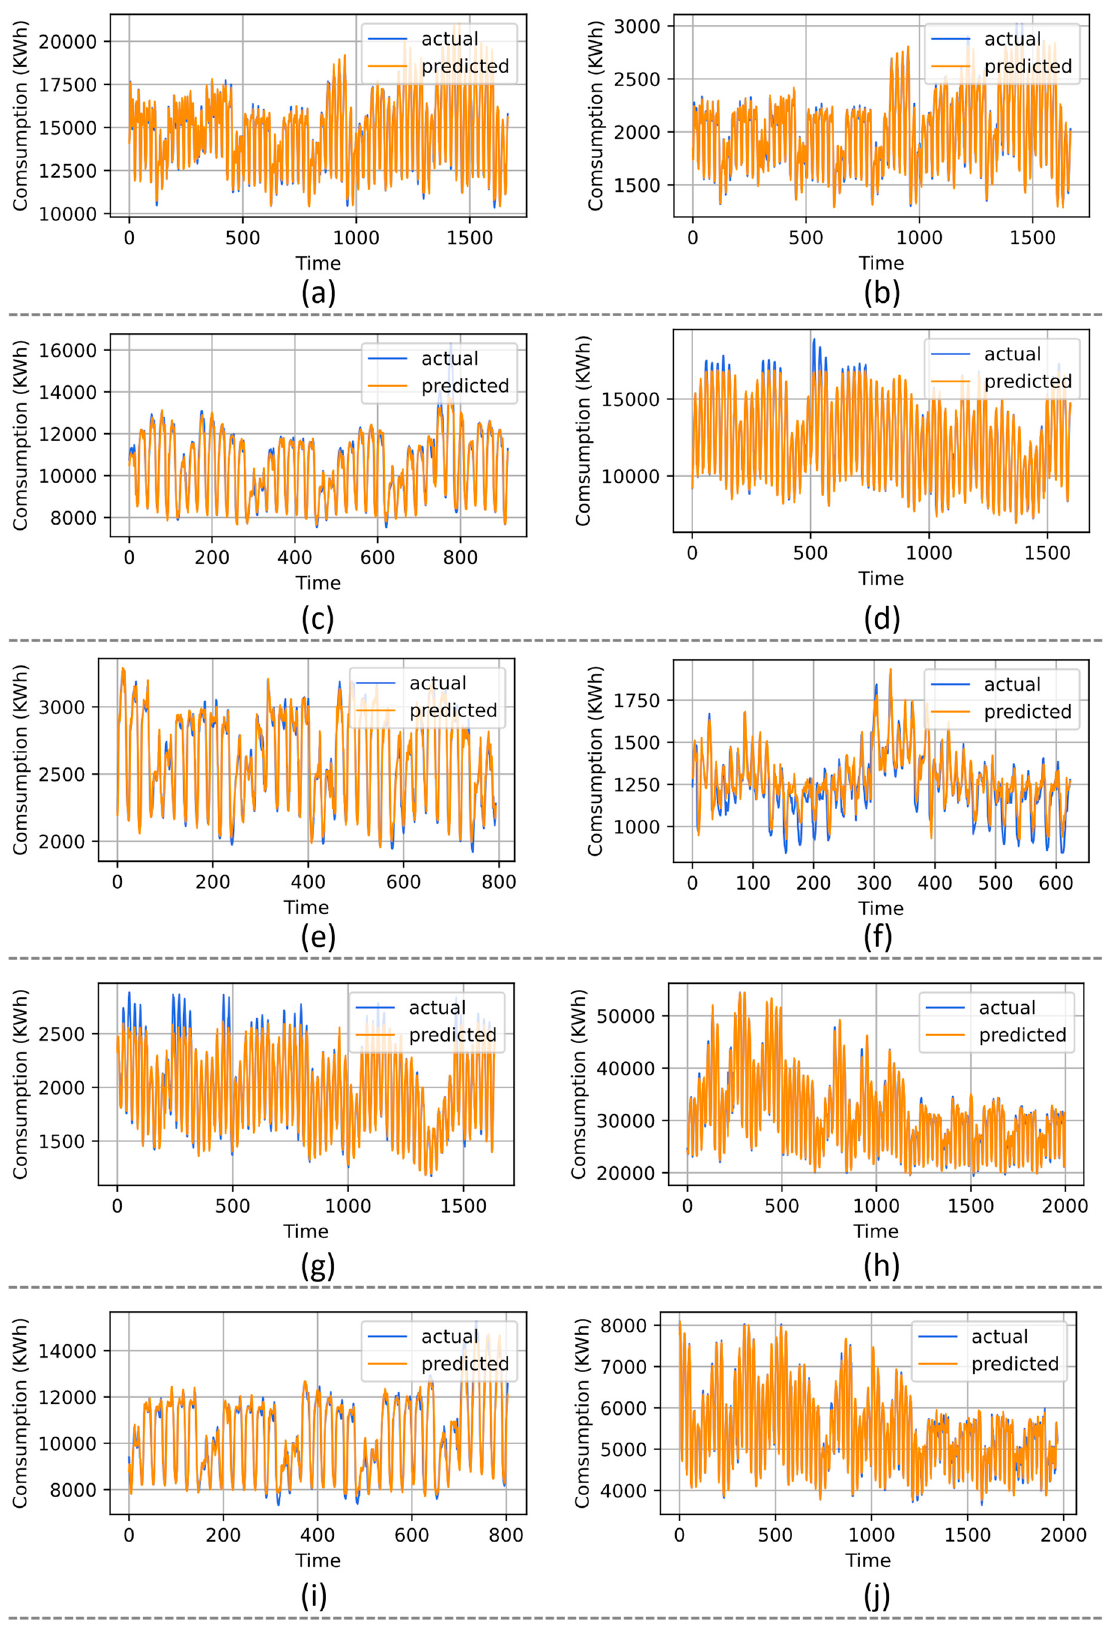
Figure 4. Visual results of the proposed model over IHEPC dataset ( a ) AEP, ( b ) DAYTON, ( c ) COMED, ( d ) DOM, ( e ) DEOK, ( f ) EKPC, ( g ) DUQ, ( h ) PJME, ( i ) NI, and ( j ) PJMW dataset.